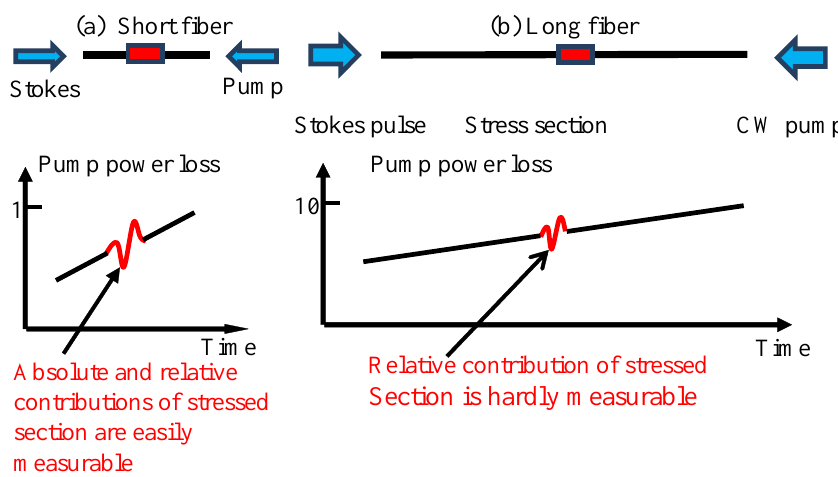
Figure 2. Small stress response in short and long fiber